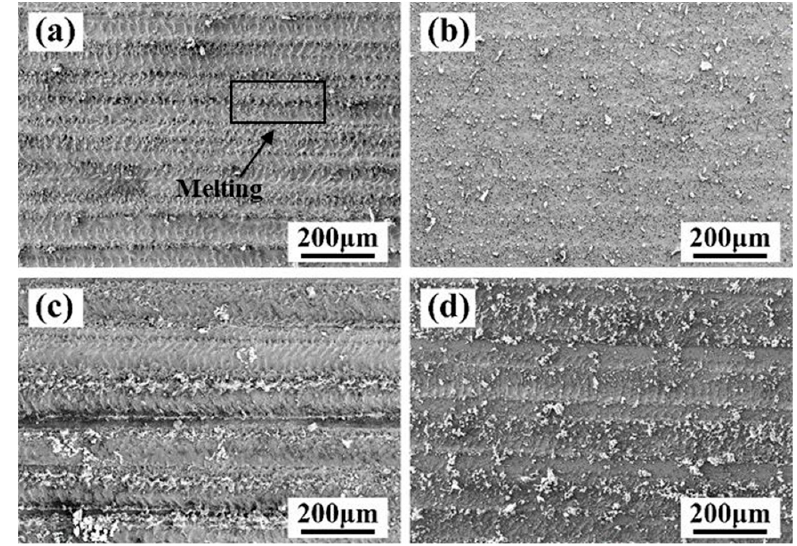
Figure 6. The effect of laser Y-moving speed on the micro-morphology of the cleaned surface. ( a ) 5 mm/s; ( b ) 7 mm/s; ( c ) 9 mm/s; ( d ) 11 mm/s at laser X-scanning speed of 1500 mm/s.